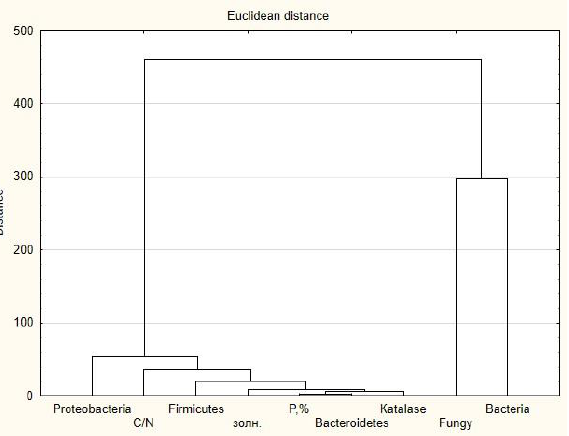
Figure 3. The data of cluster analysis of the studied microbiological and chemical indicators of soils in the gradient of the altitude zone of Mt. Kivakka.